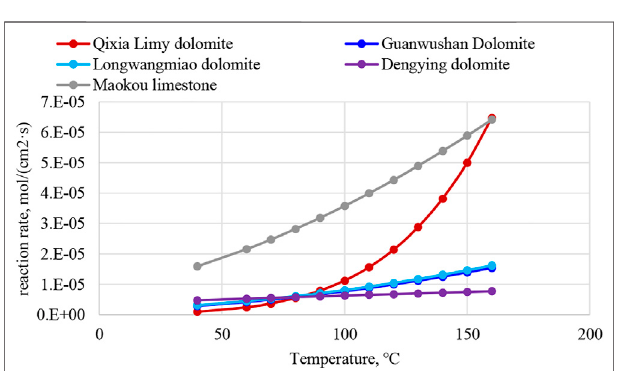
FIGURE 4 | Effect of temperature on the reaction rate of gelled acid with different carbonates.